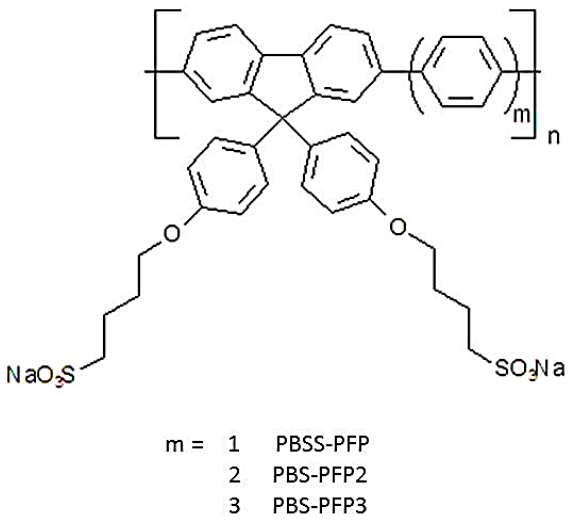
Figure 1. Structures of the fluorene-arylene conjugated polyelectrolytes studied.